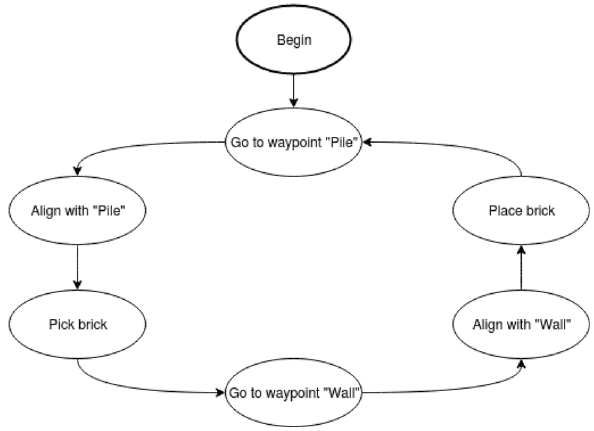
Fig. 4 Simplified diagram of the pick and place approach and the corresponding robot states for the scenario of building a wall from a pile of